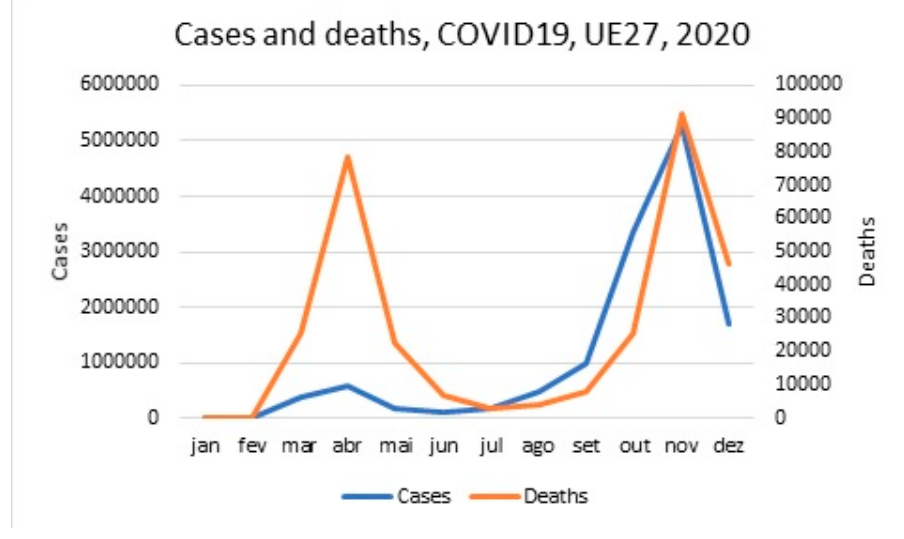
Figure 1. COVID-19 cases and deaths, 2020, UE27.